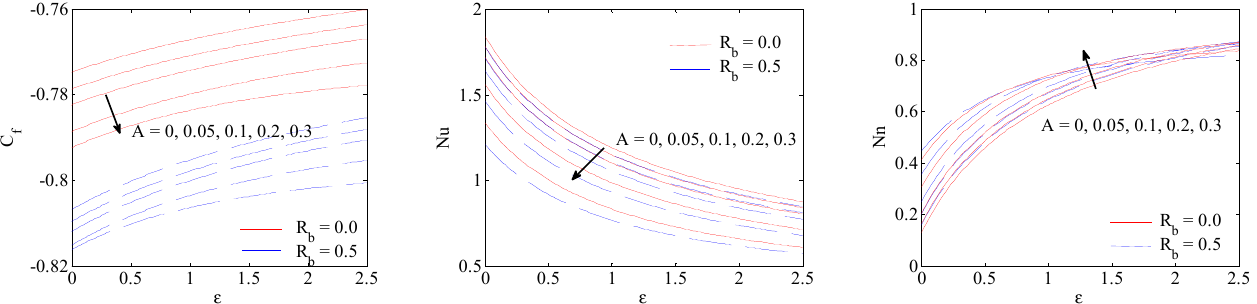
Figure 7. Fluctuations of C f , Nu and Nn due to the factor A .